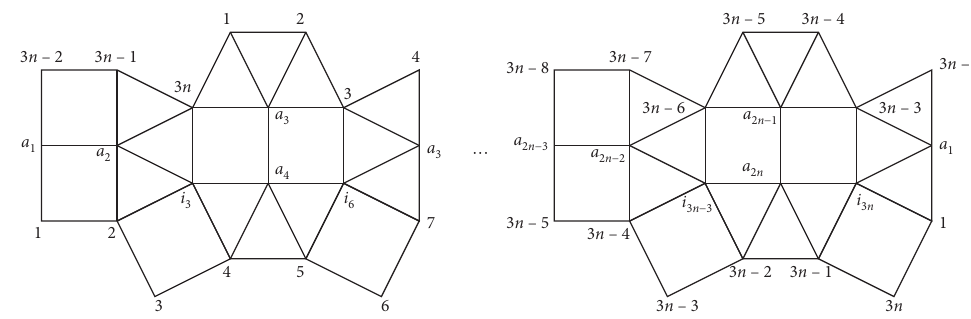
Figure 16: DSEM of type- [ 3 3 , 4 2 : 3 2 , 4 , 3 , 4 ]